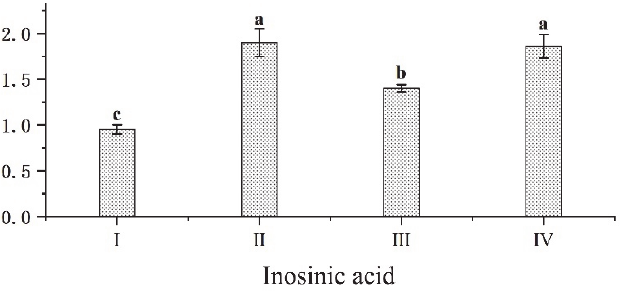
Figure 1. Effect of mulberry leaf TMR diet in different processing modes on black goat muscle inosinic acid. Different bars in the graph indicate different experimental groups. Different superscript lowercase letters in the same row (a, b, c) indicate significant differences ( p < 0.01).